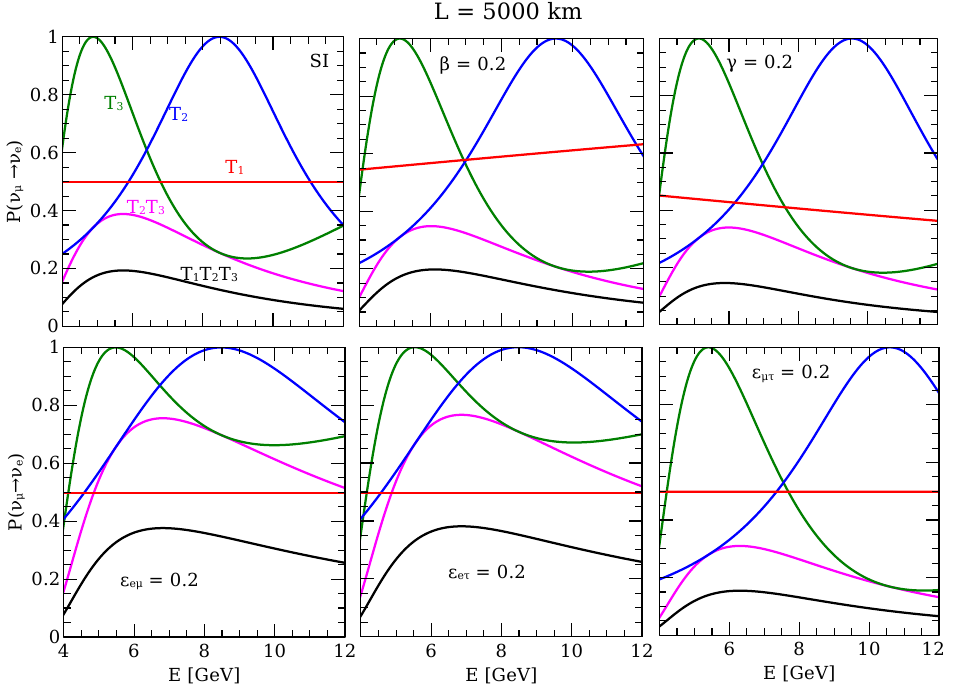
Figure 11 . Variation of ν µ → ν e transition probability (eq. (7.1)) with energy under the approxima- tion θ m → 90 ◦ for a baseline of L = 5000 km. T 1 (red curve), T 2 (blue curve), and T 3 (green curve) 12 are the three terms defined in eq. (7.1). Various panels represent the SI case and SI+NSI cases as shown in the labels. To prepare this plot, the values of the three-flavor oscillation parameters are taken from table 2. We assume θ = 45 ◦ and 23